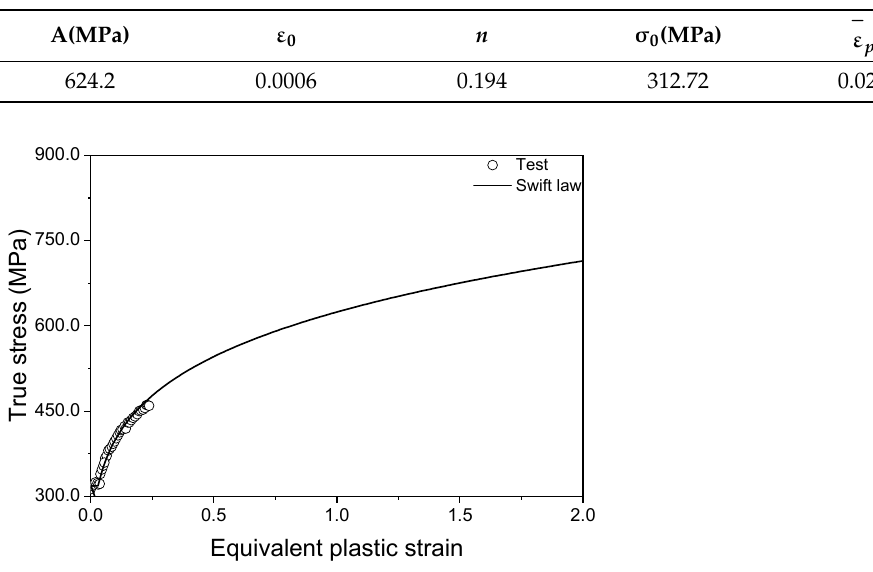
Figure 7. Flow stress beyond the onset of necking of JIS G3131 SPHC.